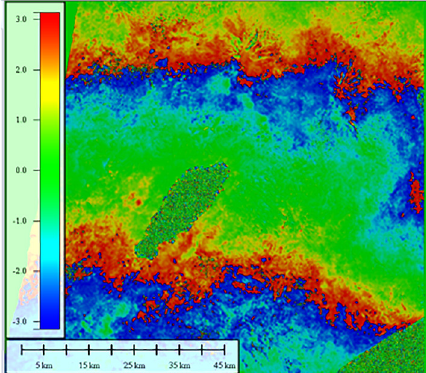
Figure 8. Phase unwrapping Fint